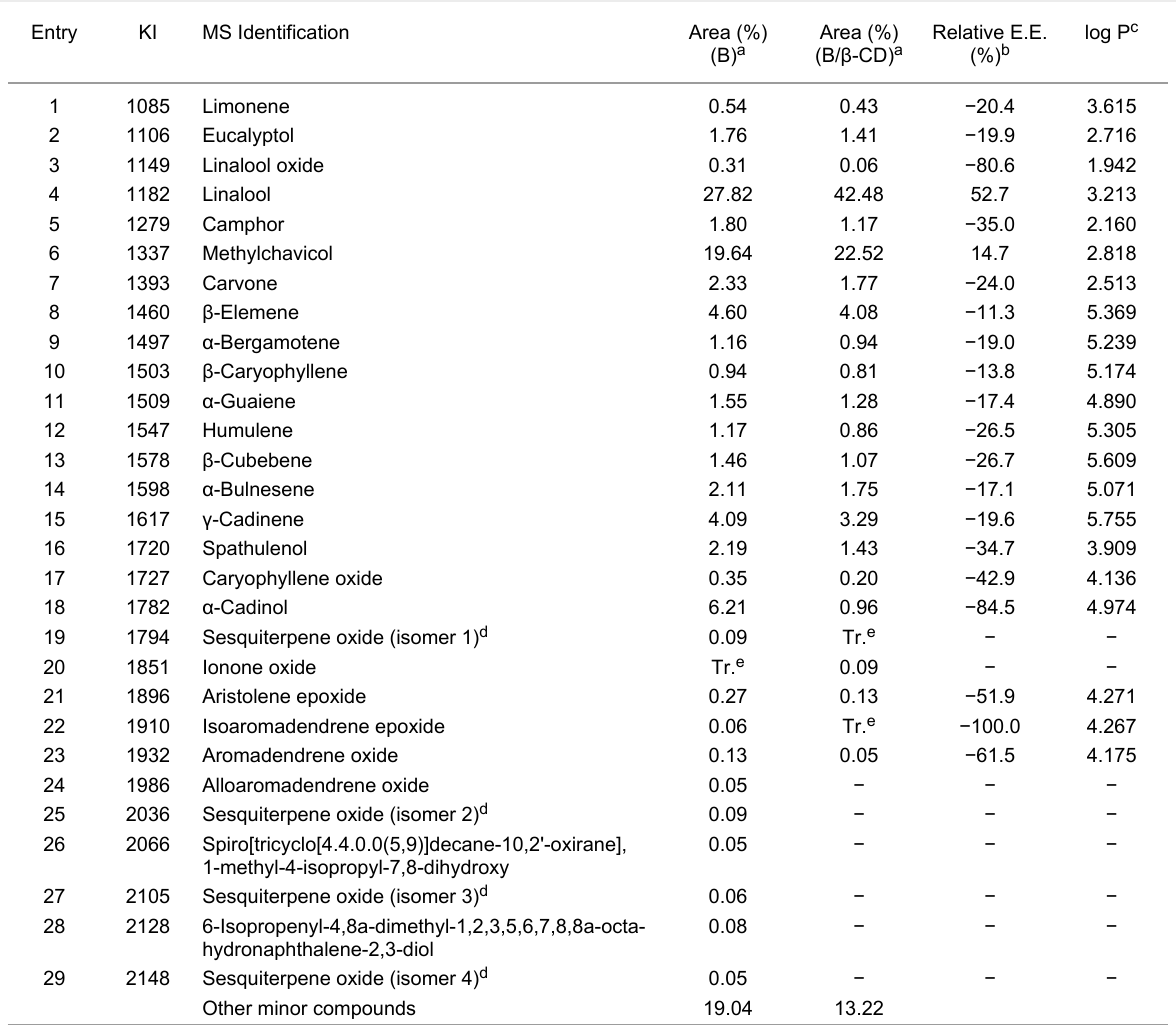
Table 1: The GC–MS data (Kovats index – KI, relative concentrations – Area (%)) of the raw (B) and recovered from β -CD complex (B/ β -CD) of O. basilicum L. essential oil, the relative encapsulation efficiency (E.E.) and the log P